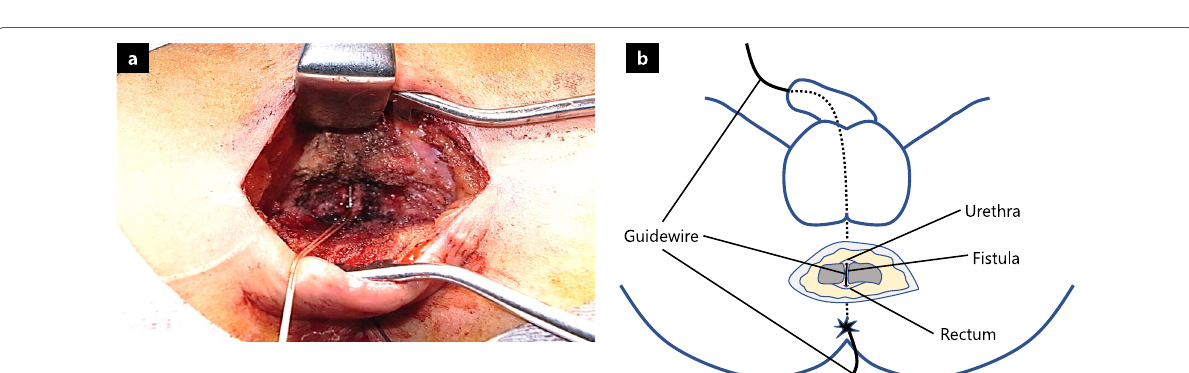
Fig. 2 Exposure of the fistula . a The guidewire passed through the fistula from the urethral meatus to the anus. b Illustration of the location of fistula, organs, and